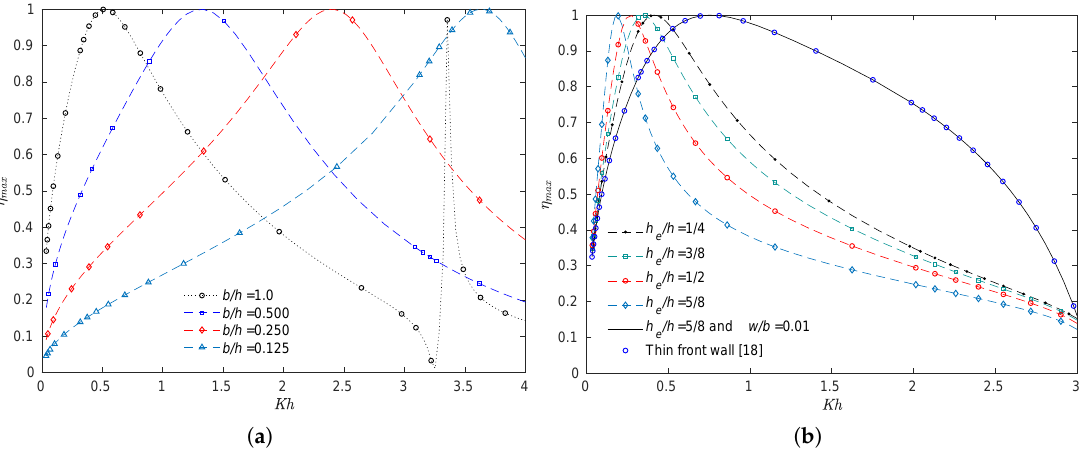
Figure 8. Hydrodynamic efficiency versus Kh . ( a ) For various wall to front barrier spacing ratios b / h with h a / h = 0.125 and w / b = 1.0. ( b ) For various step to bottom ratios h e / h with h a / h = 0.125, b / h = 1.0 and w / b = 1.0.